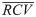
Median RCV¯ for N = 100.